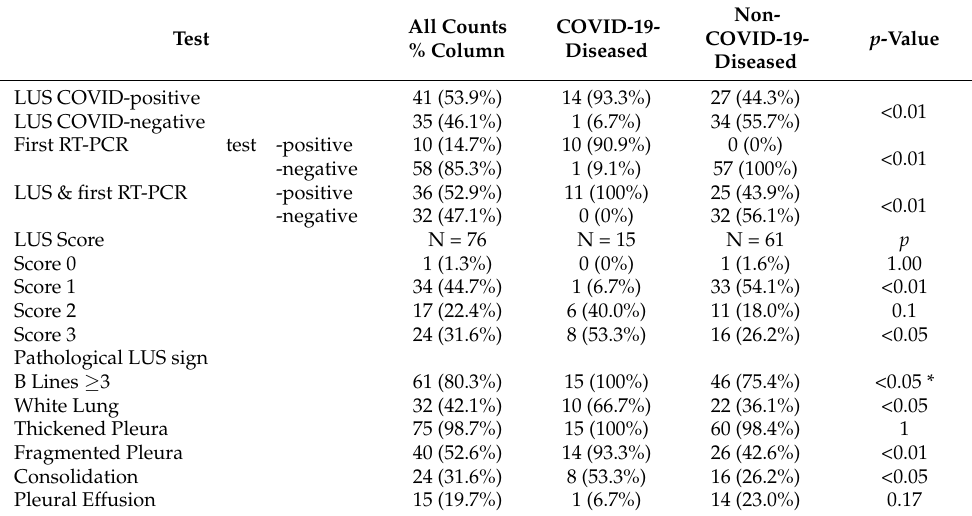
Table 3. Classification results and lung ultrasound characteristics of study